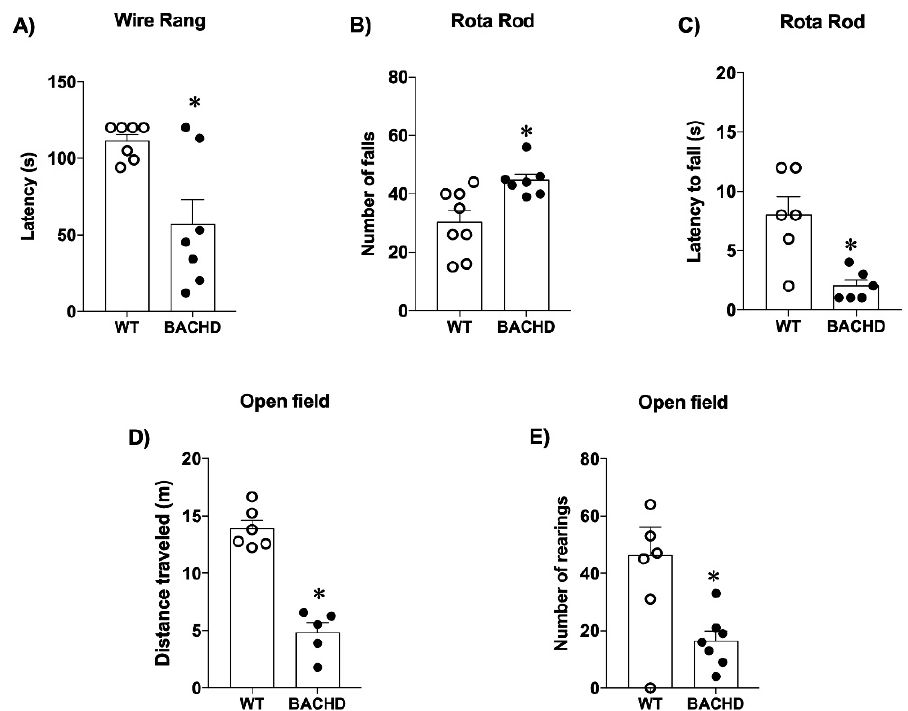
Figure 1. BACHD mice presented motor and behavioral changes. ( A ) BACHD mice showed impair- ment of muscle strength on the wire hang test. ( B ) BACHD mice exhibited an increased number of falls and ( C ) a decrease in the latency to fall in the rotarod test. ( D ) BACHD mice showed a decrease in the distance traveled on the open field and ( E ) a decreased number of rearings. Results are expressed as mean ± SEM. n = 5–7. * p < 0.05 compared with WT group. The data were analyzed by Student’s t -test.